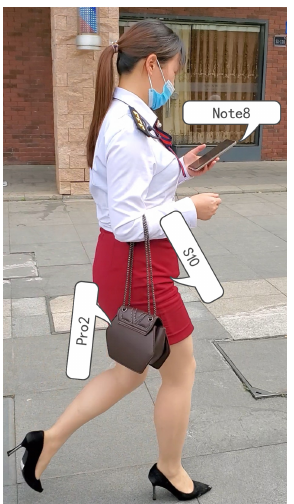
Figure 4. The locations of the different